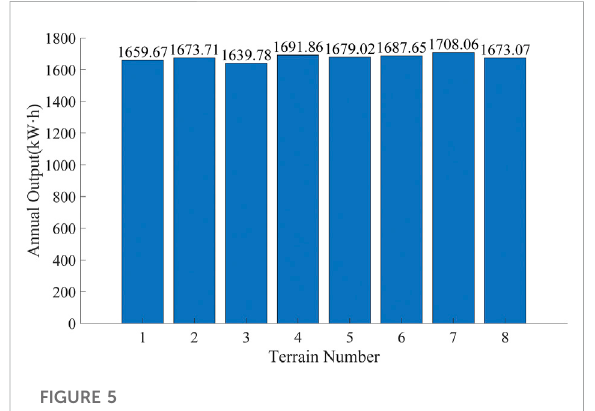
FIGURE 5 The annual expected output power of a single PV panel in each terrain.